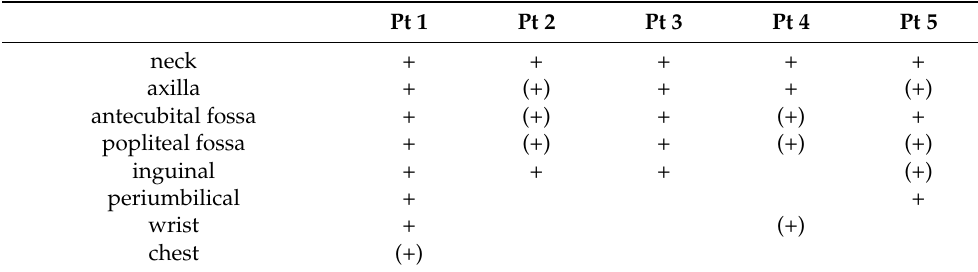
Table 2. Affected skin sites of the pseudoxanthoma elasticum patients.